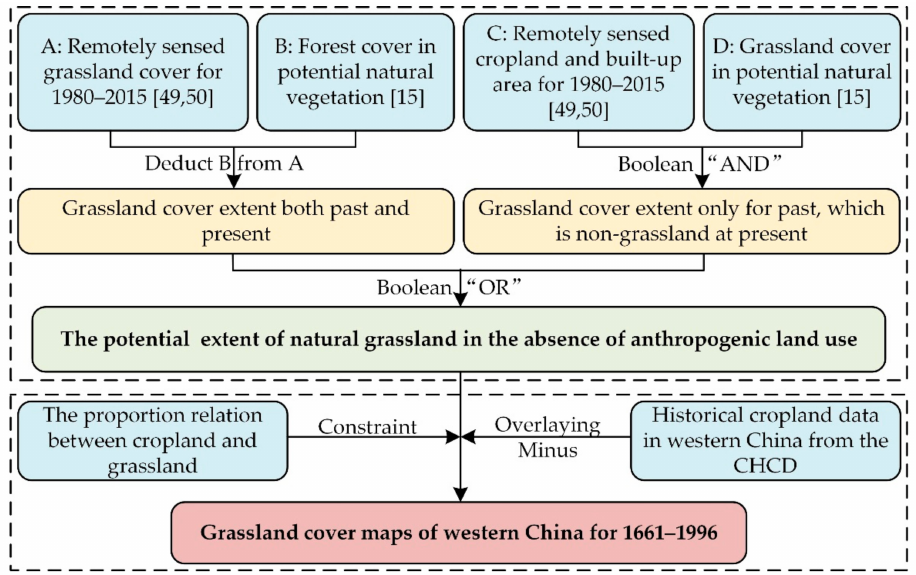
Figure 2. Proposed scheme for reconstructing historical grassland cover across western China. Abbreviation: CHCD, Chinese historical cropland dataset for the past 300